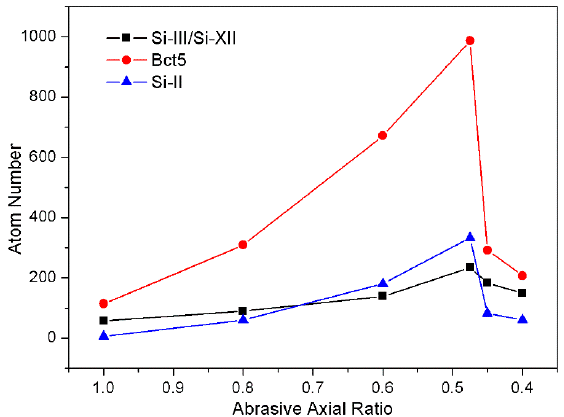
Figure 9. Atom number of the remaining transformation atoms in the scratched region.